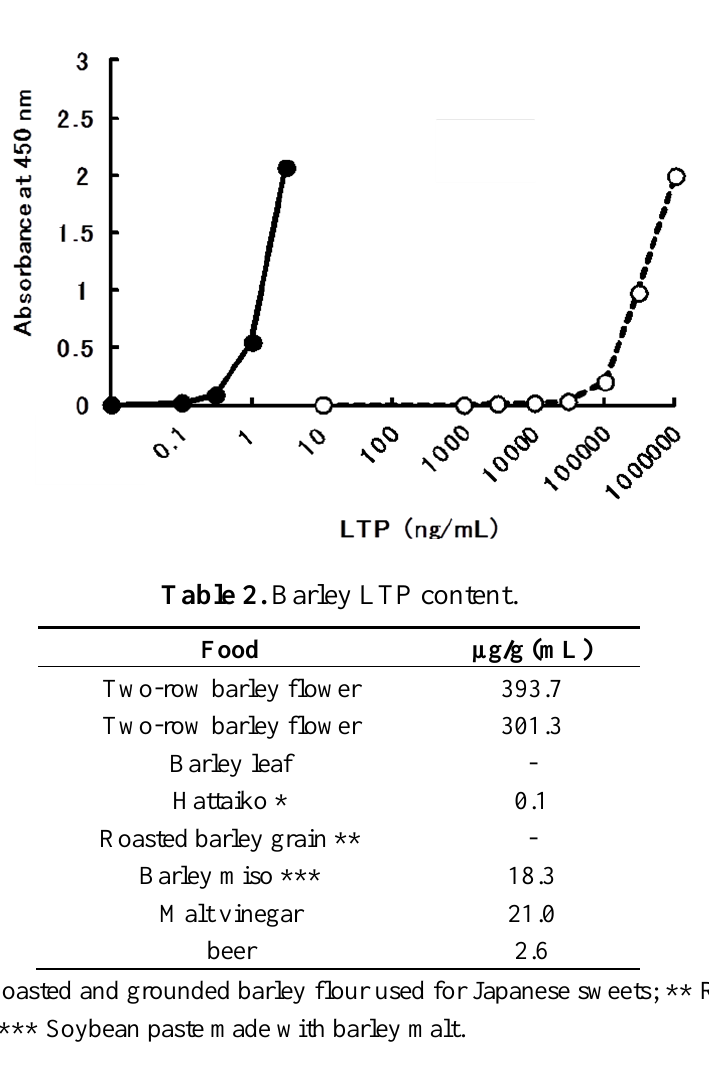
Figure 5. Reactivity of the 10-4/5-4 sandwich ELISA system to barley and wheat LTPs. Barley (●) or wheat LTP (○) was determined by the sandwich ELISA, constructed with mAb